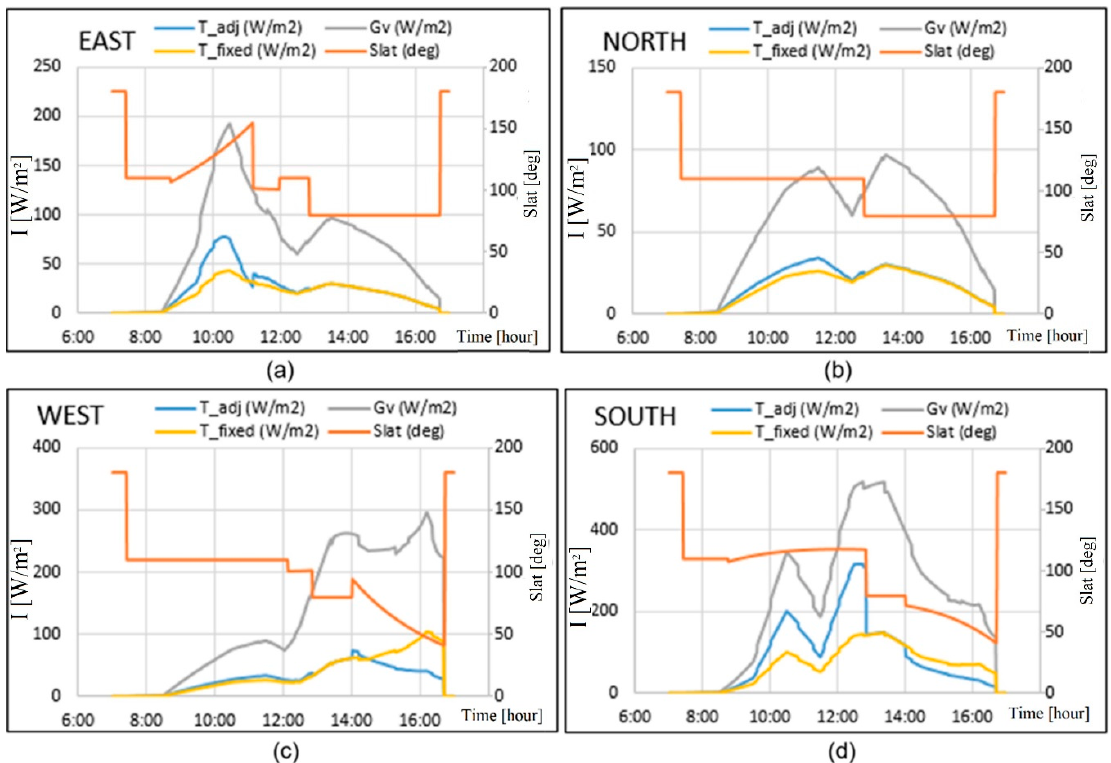
Figure 5. Irradiance and Slat angle in winter day for different exposure: ( a ) East ( b ) North ( c ) West ( d ) South.